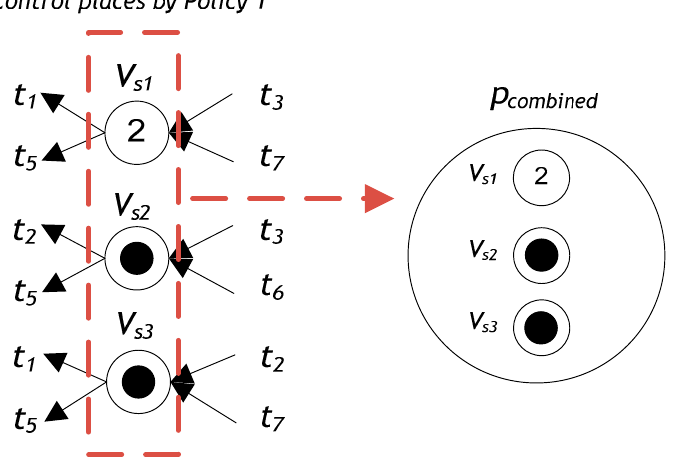
Figure 3. Merged control place for all monitors P V .